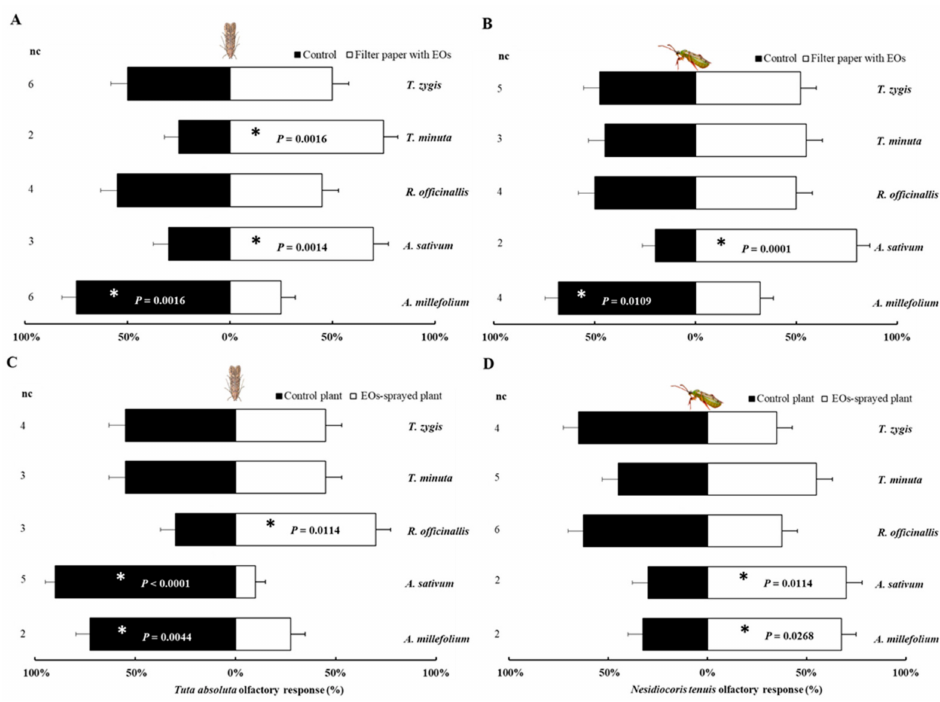
Figure 1. Response of the herbivore Tuta absoluta and the natural enemy Nesidiocoris tenuis females to plant essential oils, using a Y-tube olfactometer. ( A , B ) T. absoluta and N. tenuis were exposed to filter paper sprayed or not with PEOs. ( C , D ) T. absoluta and N. tenuis response to tomato plants previously sprayed with PEOs. The means of 40 repetitions in each treatment ± SE. nc (no choice) is the number of individuals that did not make a choice. Asterisks indicate significant differences in the distribution of side-arm choices ( χ 2 tests; p <